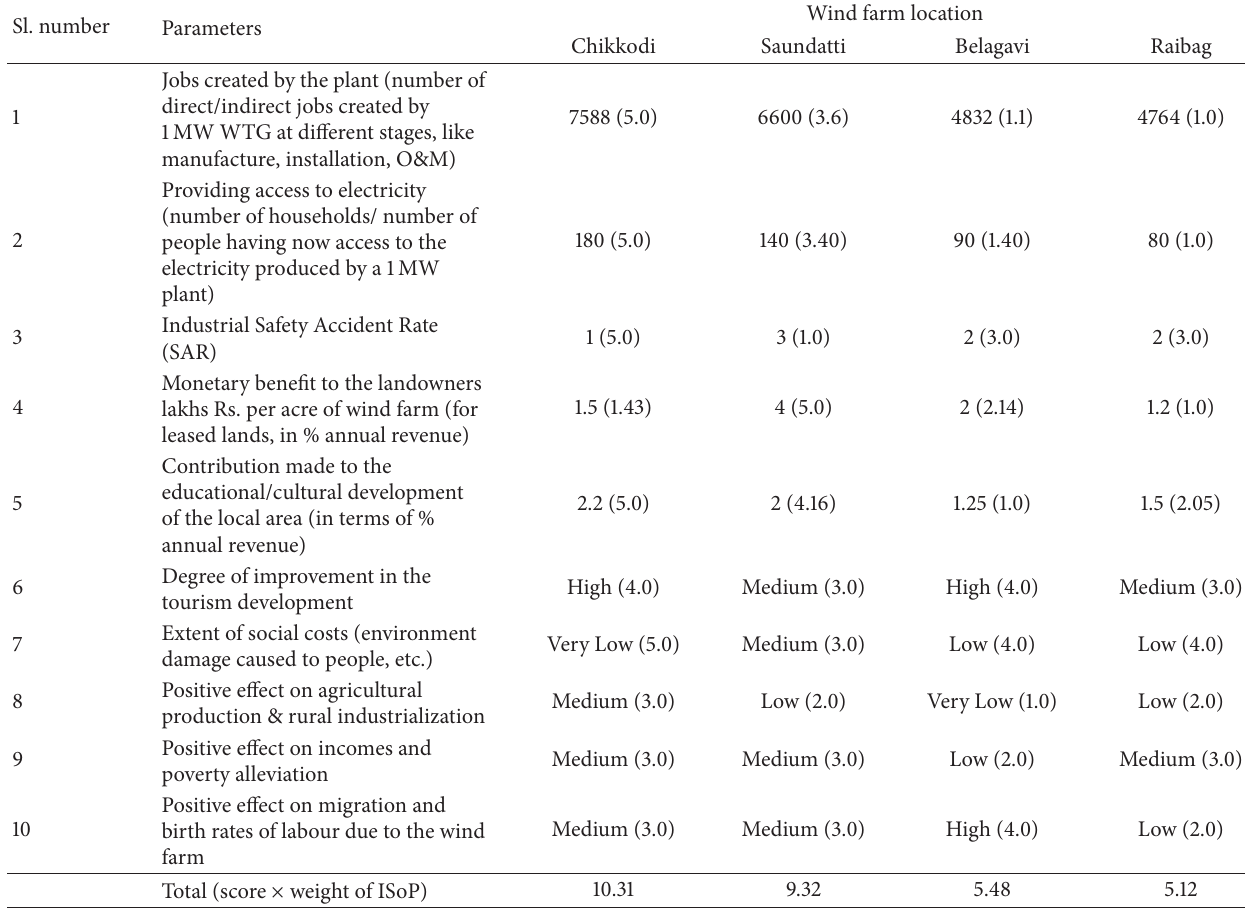
Table 5: Comparison of the wind farms based on sociological performance indicators (ISoP). Sl. number